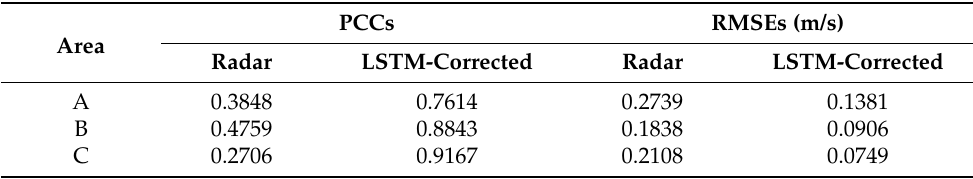
Table 1. Domain-averaged PCCs and RMSEs in areas A, B, and C.